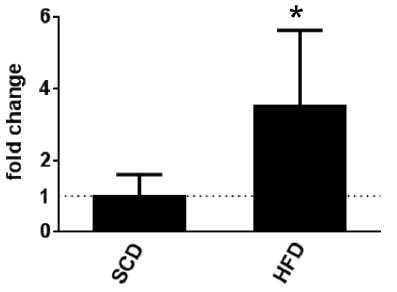
Figure 1. HFD increases dusp2 mRNA expression. Dusp2 mRNA expression in the WAT of wt C57Bl6J mice fed either SCD or HFD for 12 weeks. * p , 0.05. Data are mean 6 SD. N=5 for SCD and 8 for HFD.